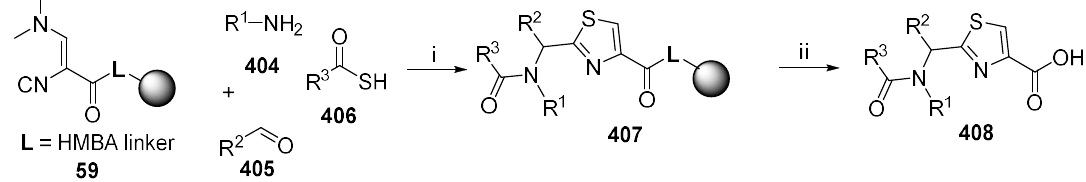
Scheme 67. Synthesis of thiazoles on Rink amide resin.